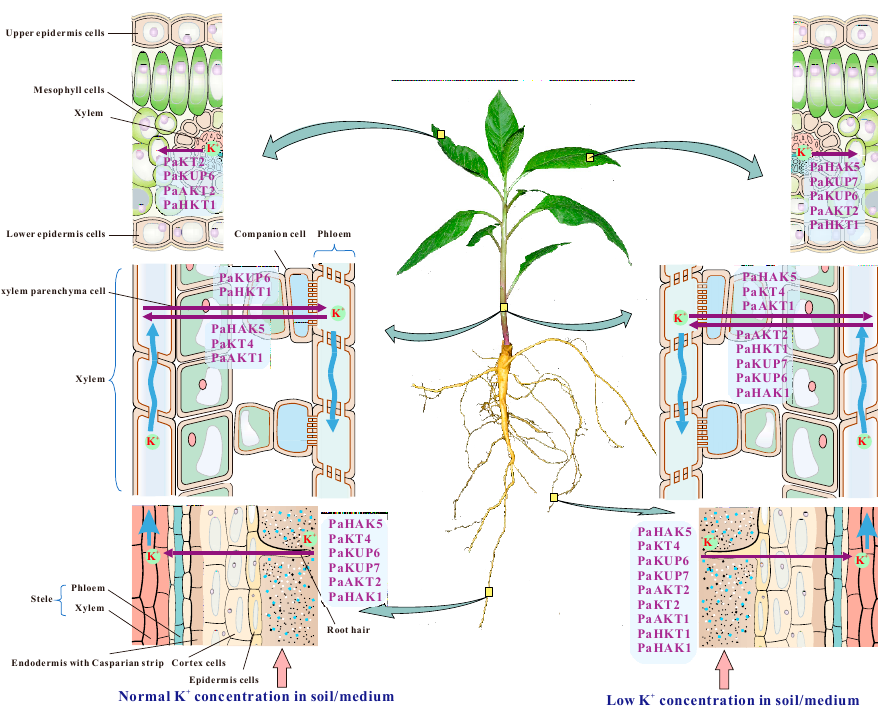
Figure 8. Model of K + uptake/transport mediated by high-affinity K + transporters.